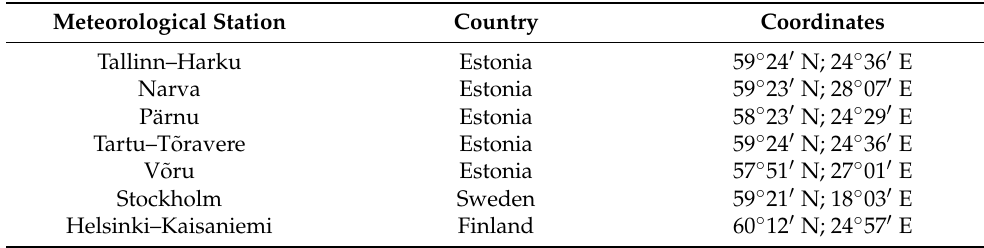
Table 1. Locations of meteorological